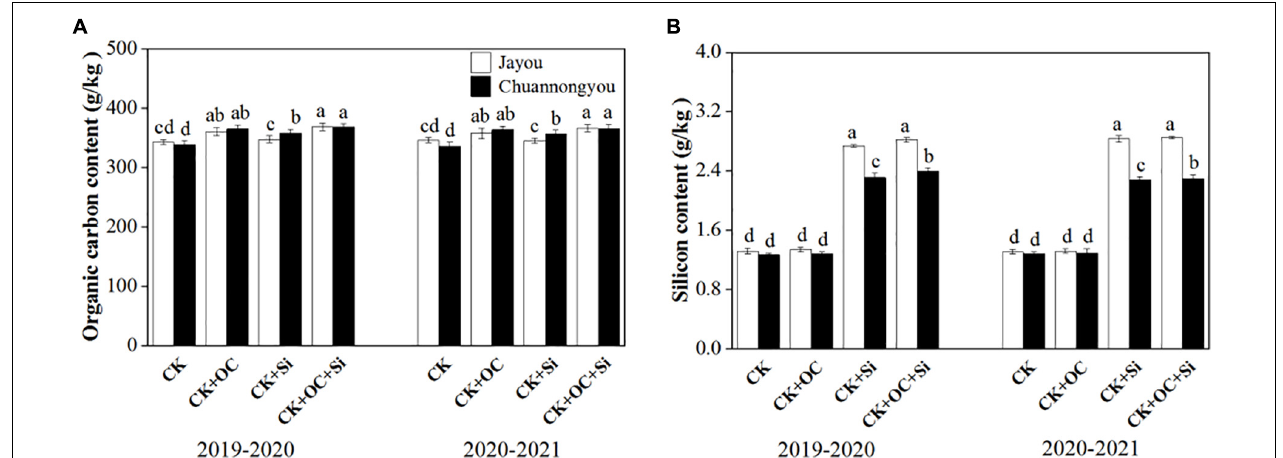
FIGURE 7 | Effect of different fertilization on organic stem carbon (A) and silicon content (B) of rapeseed. Different lower-case letters indicate significant differences among treatments at p < 0.05 (LSD test) with the means ( n = 3) of values. The CK, CK + OC, CK + Si, and CK + OC + Si represent the conventional fertilization, conventional + organiccarbon fertilization, conventional + silicon fertilization treatment, and conventional + organic carbon + silicon fertilization treatment.